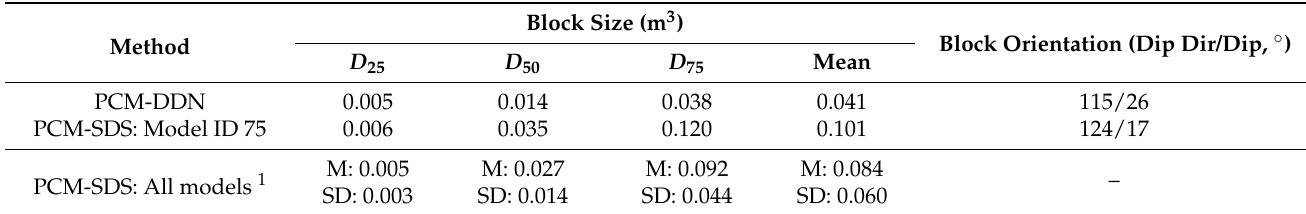
Figure 12. The block volume distribution of IBSD D and IBSD S . All color curves represent IBSD S from PCM-SDS of all simulated models.